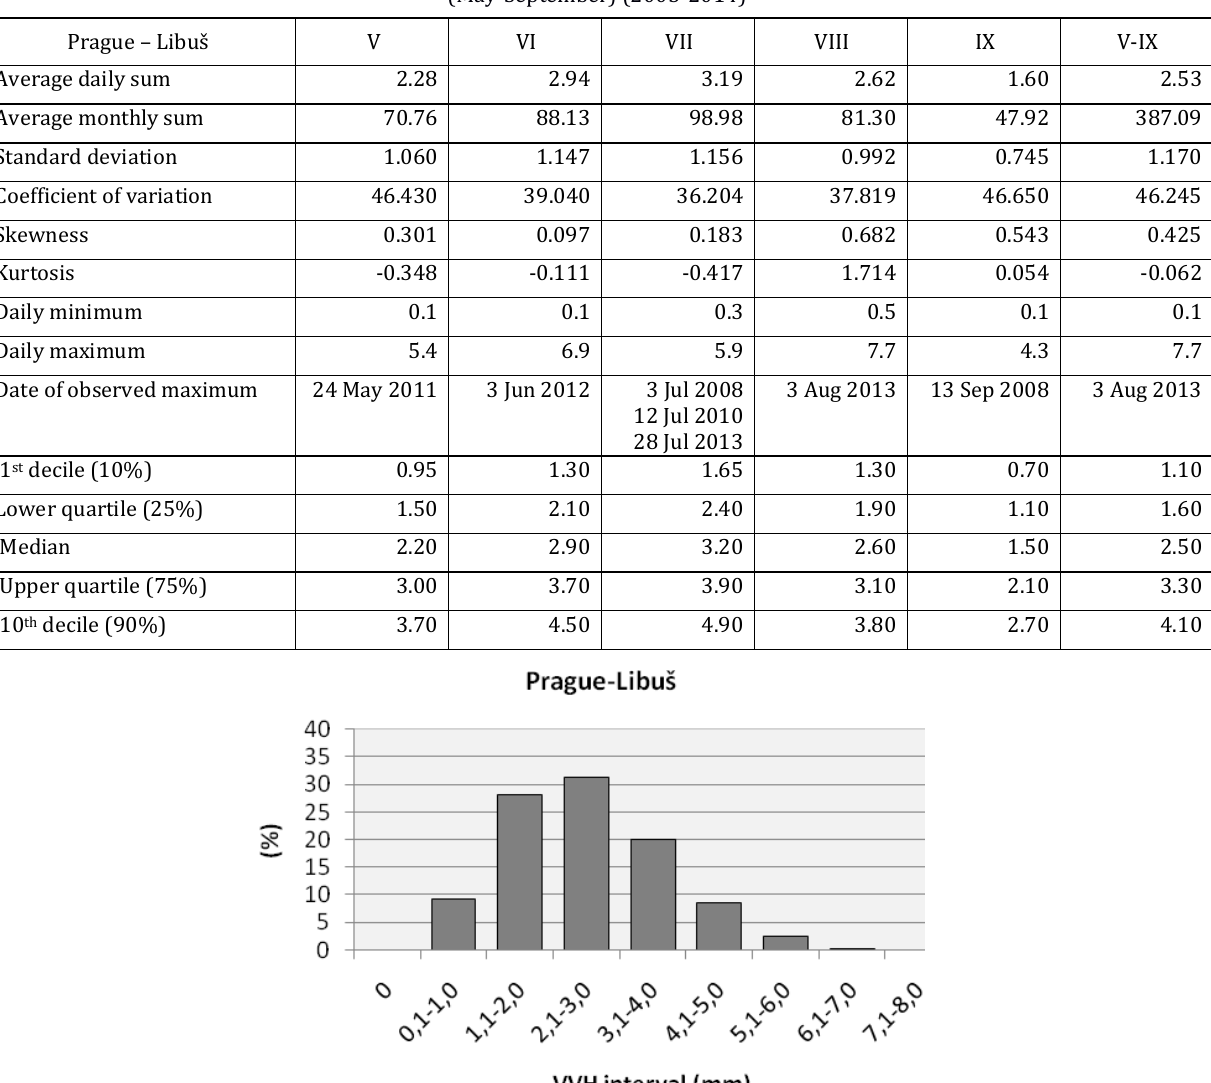
Fig. 6. Prague-Libuš, frequency of daily evaporation totals from water surface for the specified intervals